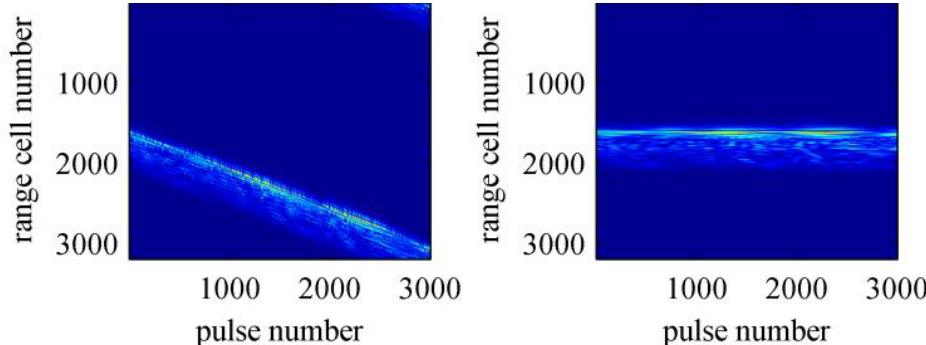
Figure 6. HRRP of Tiangong-1 collected from the measurement of inverse synthesis aperture radar. ( left ) Original HRRP of Tiangong-1; ( right ) aligned HRRP of